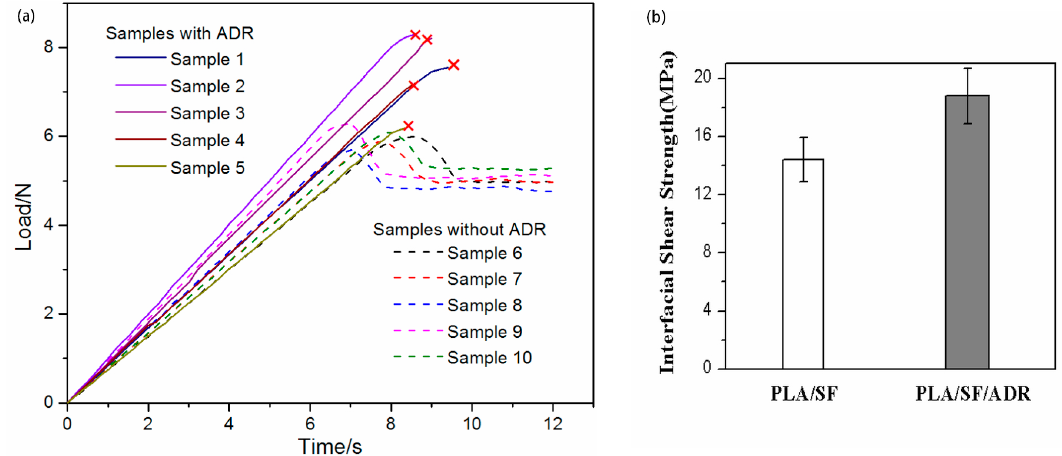
Figure 7. Curves of load vs time ( a ) and interfacial shear strengths (IFSS) ( b ) of micro-debond test samples with and without ADR.